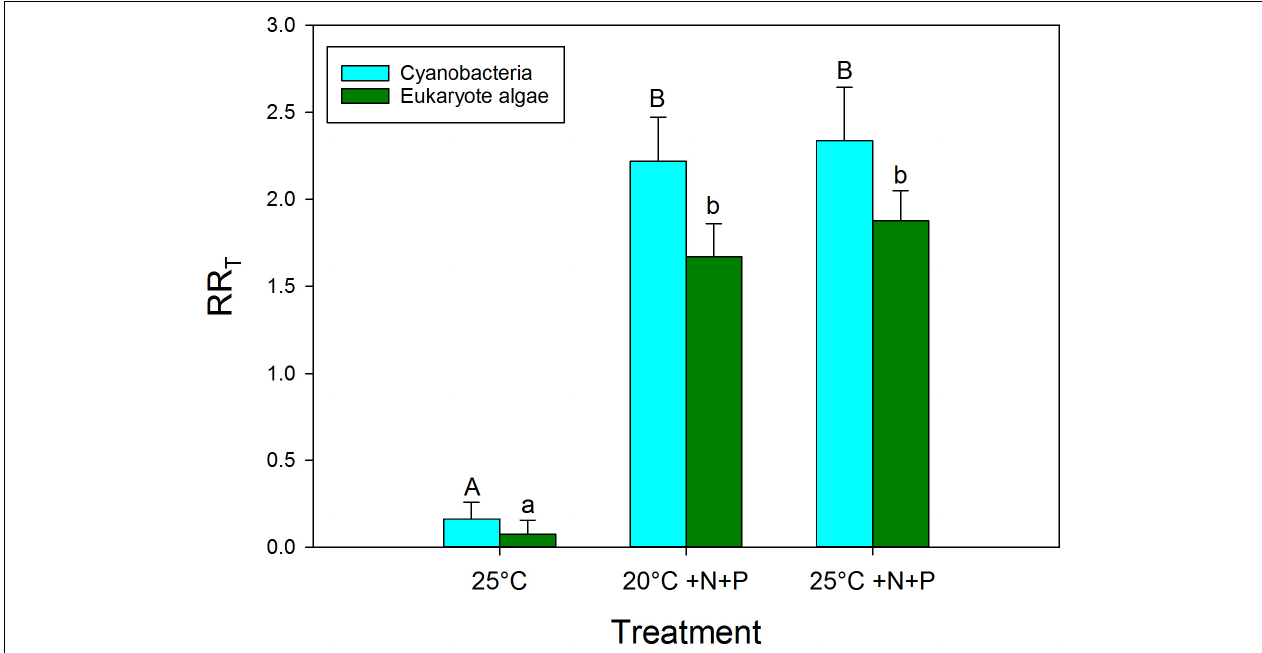
FIGURE 3 | Response ratios (RR T ), which is the natural logarithm of the quotient of chlorophyll-a concentration ( µ g l − 1 ) in a nutrient addition or warming treatment and control (20 ◦ C), for cyanobacterial chlorophyll-a concentrations (blue) and eukaryote phytoplankton chlorophyll-a concentrations (green) in warmed (25 ◦ C), nutrient enriched (20 ◦ C +N+P) and both warmed + nutrient enriched (25 ◦ C +N+P) incubations. Error bars indicate 1 SD. Different letters above the bars, indicate for cyanobacteria and for eukaryote phytoplankton significant difference between